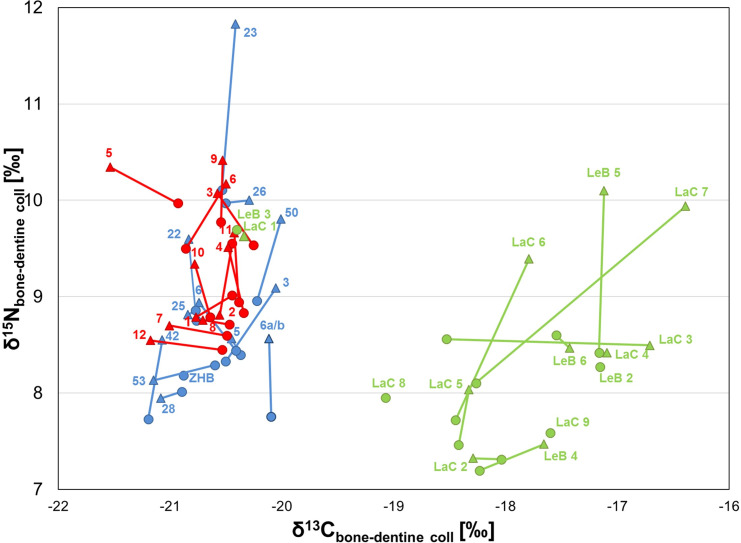
Scatter plot of the δ13C and δ15N values of dentine (triangle) and bone (circle) collagen at the three sites.Data points are labelled with grave numbers.